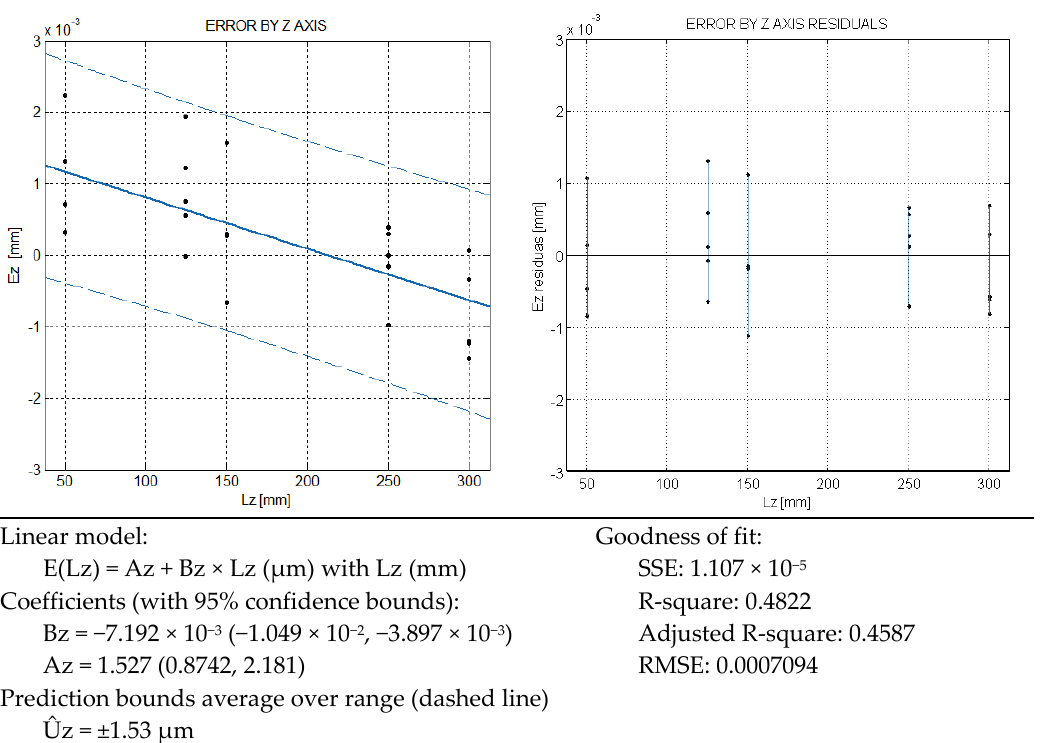
Figure 5. CMM error model by Z axis.